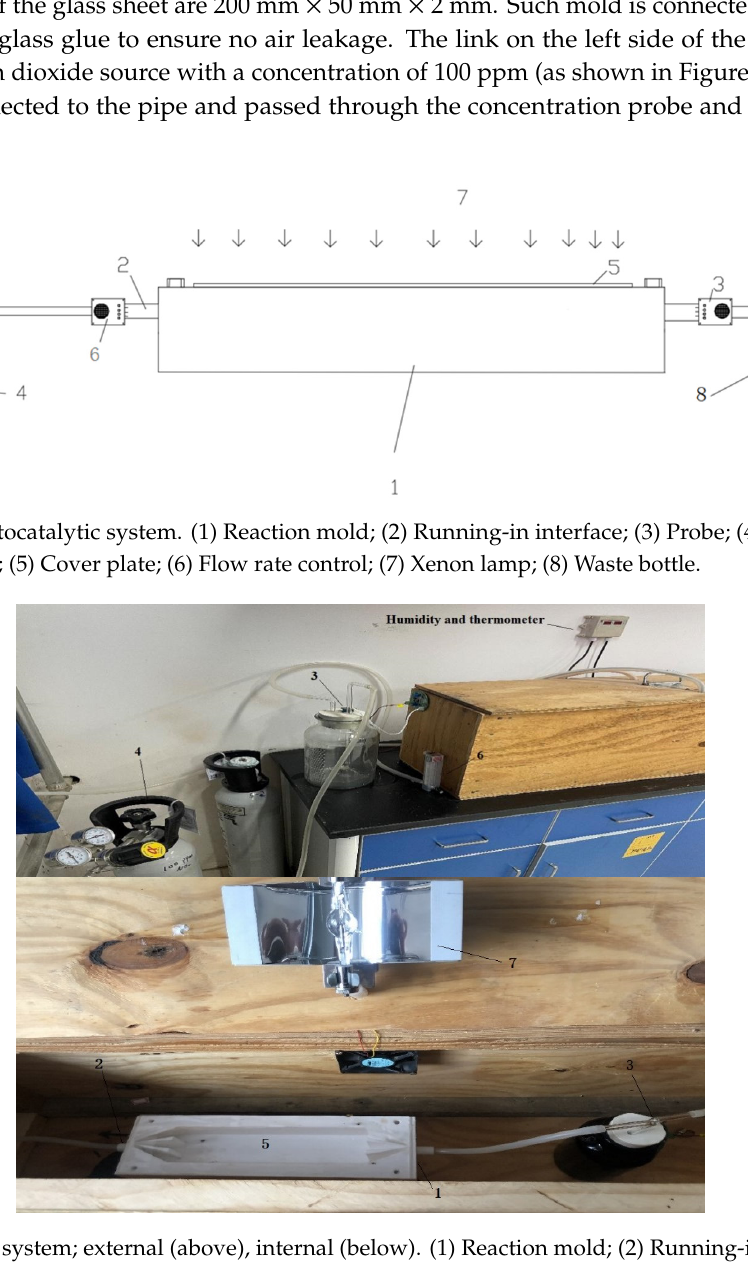
Figure 2. Test system; external (above), internal (below). (1) Reaction mold; (2) Running-in interface; (3) Probe; (4) Nitrogen dioxide bottle; (5) Cover plate; (6) Flow rate control; (7) Xenon lamp.